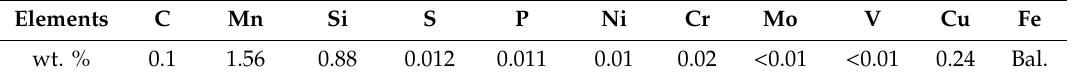
Table 1. Typical chemical composition for electrode wire ER70S-6 (weight percentage).